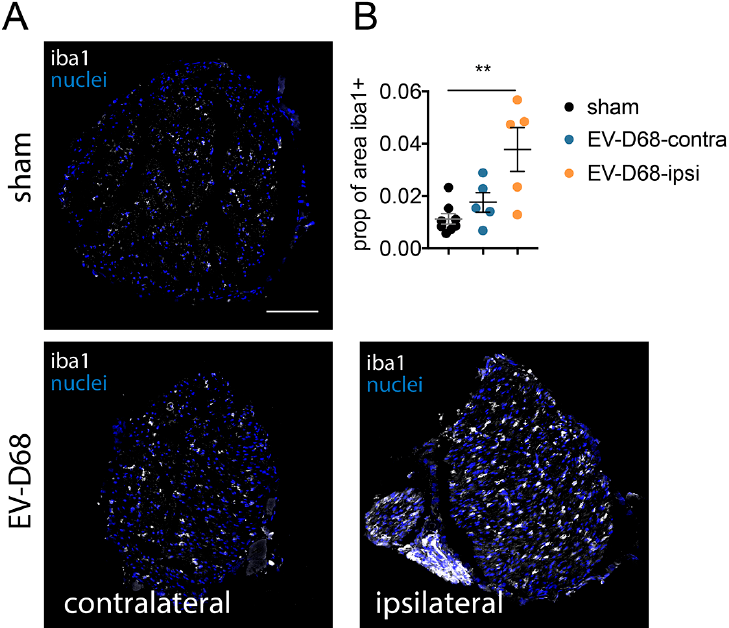
Figure 7. Myelin basic protein (MBP) ir and NF ir in sciatic nerves of EV-D68-infected mice 6 weeks after paralysis onset compared to sham. ( A ) sham; ( B ) contralateral EV-D68 sciatic nerve; ( C ) ipsilateral EV-D68 sciatic nerve; ( D ) enlargement of boxed area in B showing myelin sheaths containing degenerating axons (asterisk); ( E ) # myelinated axons; ( F ) # degenerating axons; ( G ) # unmyelinated axons; ( H ) # empty myelin sheaths. No statistical differences between groups. Scale bars = 100 µm in A ( A – C are same scale); 25 µm in ( D ). Viruses 2018 , 10 , 33